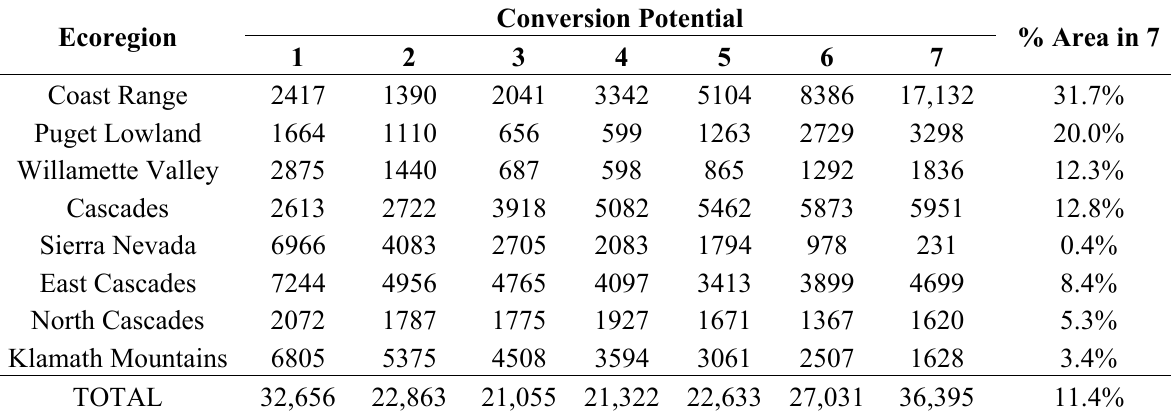
Table 5. Conversion potential by ecoregion area (km 2 ) in the Pacific Northwest by 2100. Values 1–7 represent the number of scenarios projecting land-use conversion over the modeled